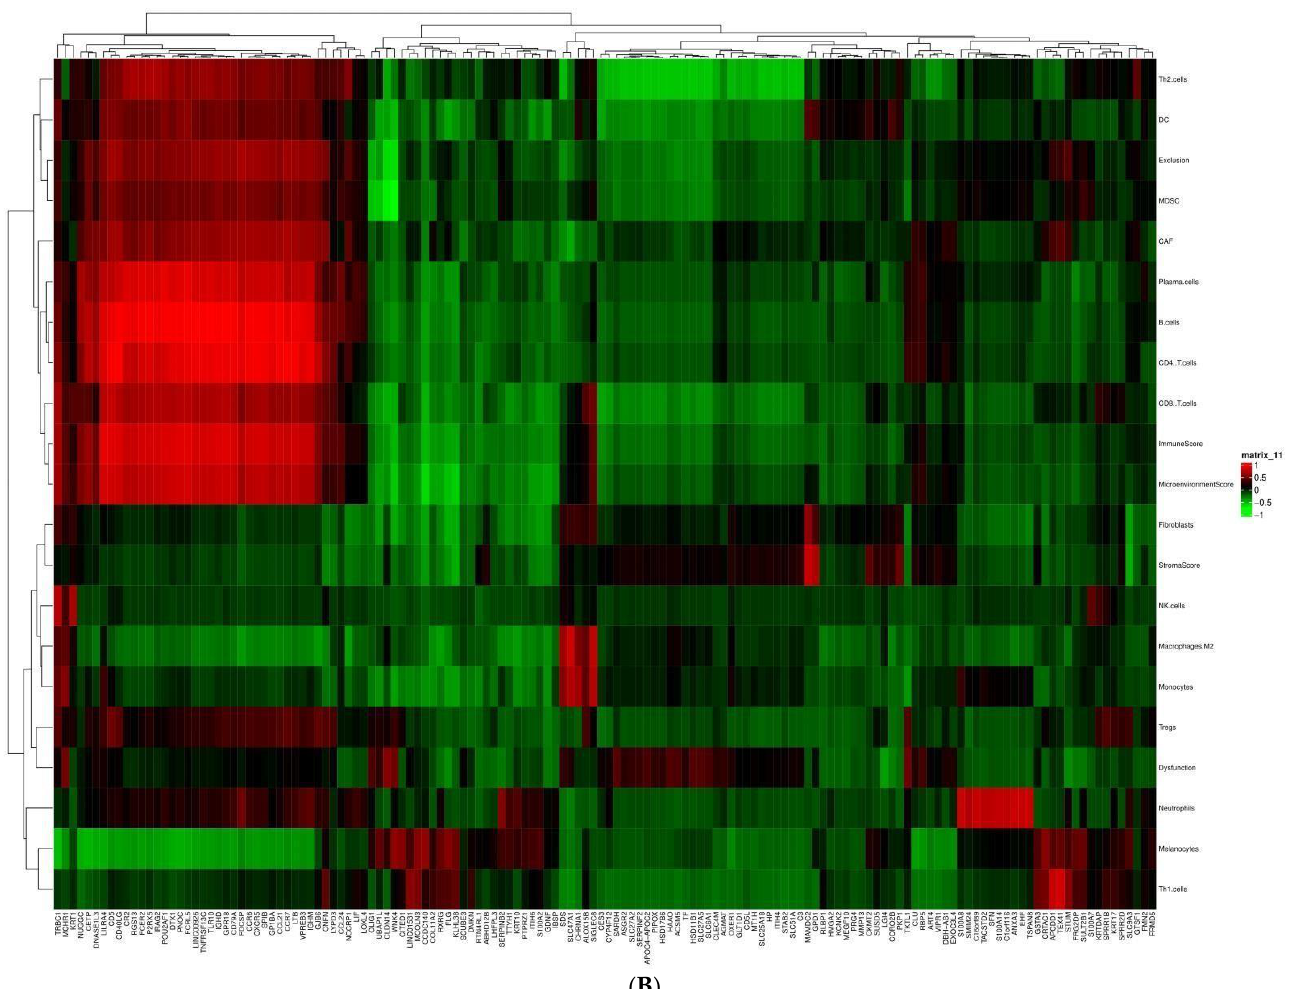
Figure 3. DEGs and the landscape of TME: ( A ) Volcano plot showing the DEGs based on response to ICI in GSE91061 as blue dots denote upregulated genes ( 𝑙𝑜𝑔 2 𝐹𝐶 > 0.5) while red dots denote downregulated genes ( 𝑙𝑜𝑔 2 𝐹𝐶 < −0.5 ). ( B ) Dendrogram of the DEGs and their association with the TME. Table 2. Evaluation metrics scores for each response model.